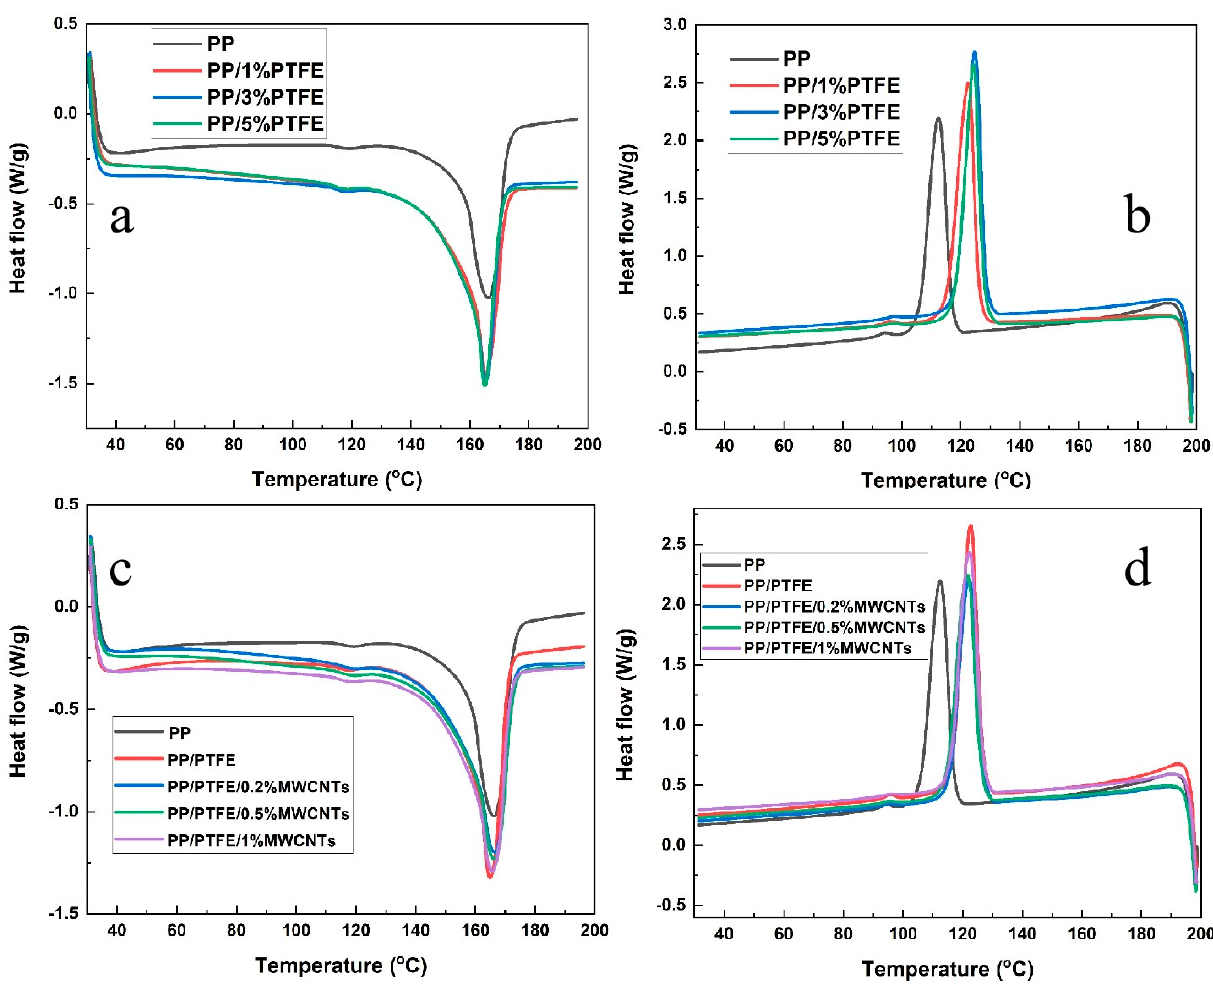
Figure 6. DSC curve of PP/PTFE composites with different contents of PTFE ( a ) heating; ( b ) cooling; DSC curve of PP/PTFE/MWCNTs composites with different contents of MWCNTs ( c ) heating; ( d ) cooling. Table 4. Thermal parameters of DSC.